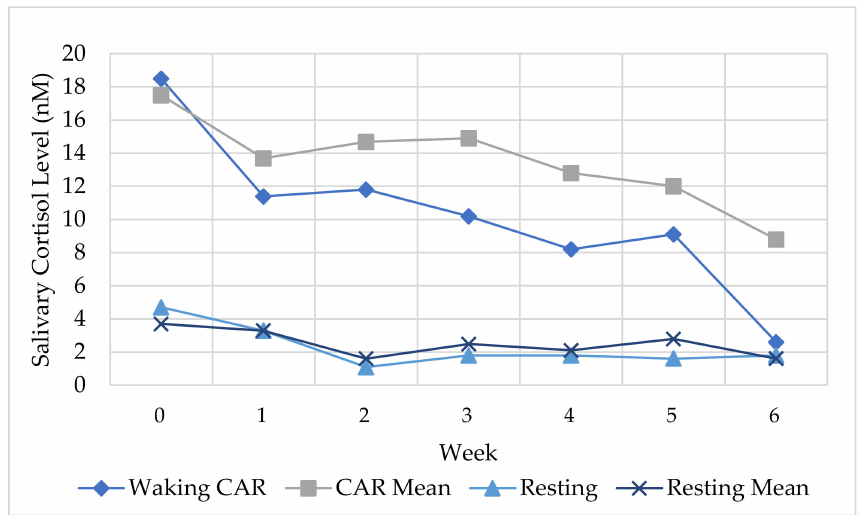
Figure 7. Change in waking (CAR) and resting salivary cortisol levels from week 0 to week 6 for Ashley.